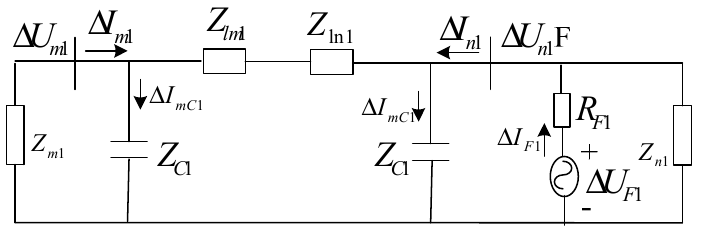
For the two-terminal power supply linear system in Figure 2, if the fault occurs near the power supply side, it is an out-of-area fault for protection. Figure 5 shows the positive sequence network diagram of fault components when out-area faults occur on the line. In Figure 5, ∆ I mC 1 and ∆ I nC 1 are the positive sequence currents of fault components that flow through the two corresponding sequence capacitors of the lines.